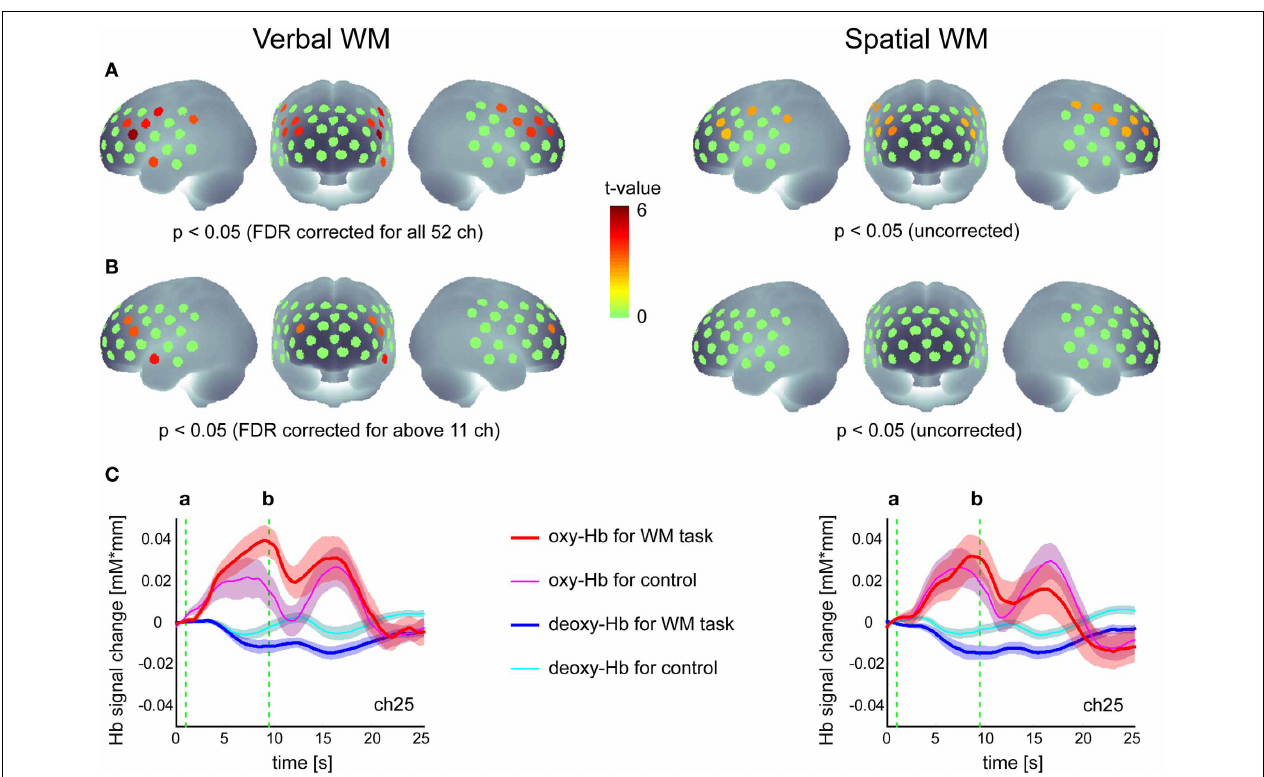
FIGURE 2 | Hemodynamic responses to the verbal and spatial WM tasks. (A) Activation t-maps of oxy-Hb signal increase during WM tasks compared to the baseline (zero level). (B) Activation t-maps of oxy-Hb signal increase during WM tasks compared to the signal during the control task. In both maps, the Student’s t -value is indicated by a color scale for channels which